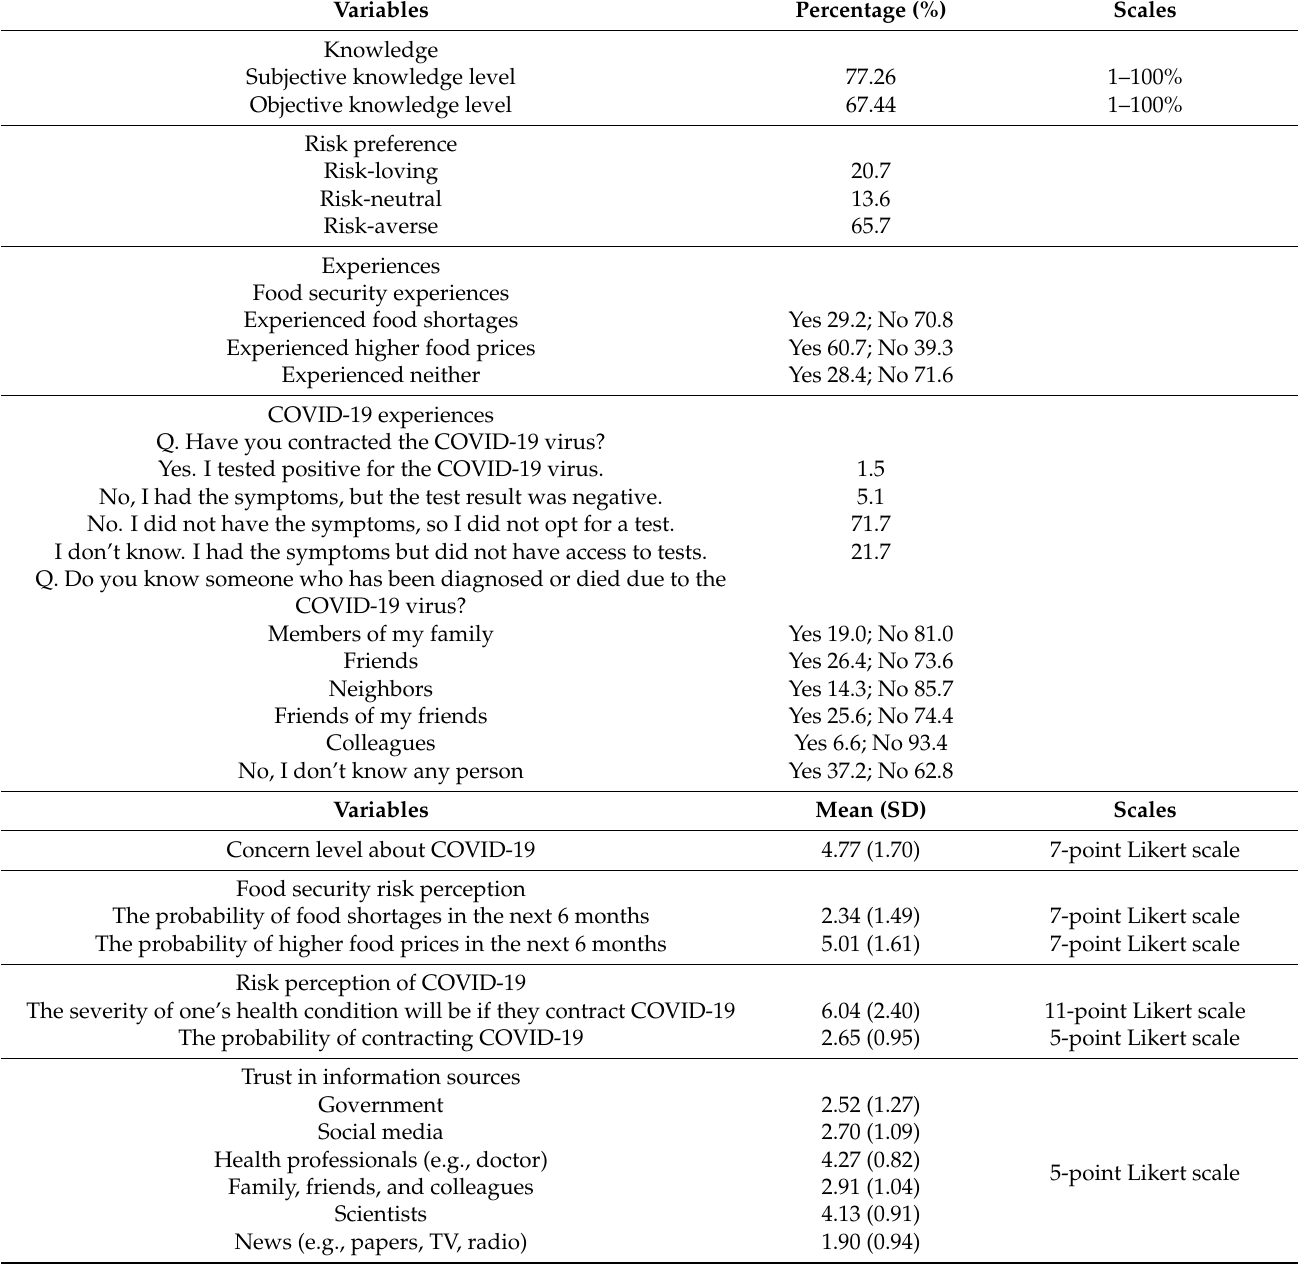
Table 2. Results of the independent variables included in the logit